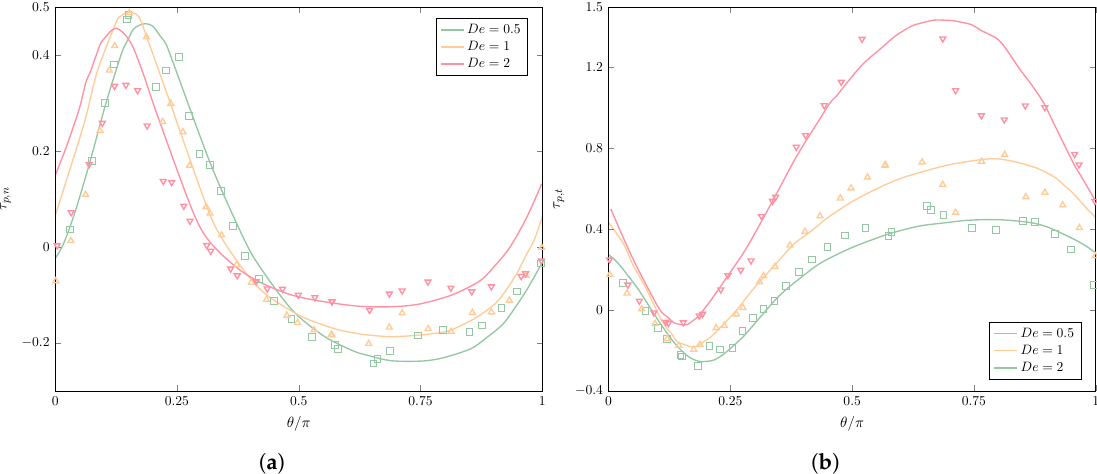
Figure 6. Comparison of the ( a ) normal and ( b ) tangential stresses along the inner edge of the interface for a non-Newtonian (Oldroyd-B) drop in a Newtonian matrix of equal viscosity, for increasing values of the Deborah number, between our results ( De = 0.5, green squares; De = 1, yellow triangles; De = 2, inverted red triangles) and those found in Yue et al.